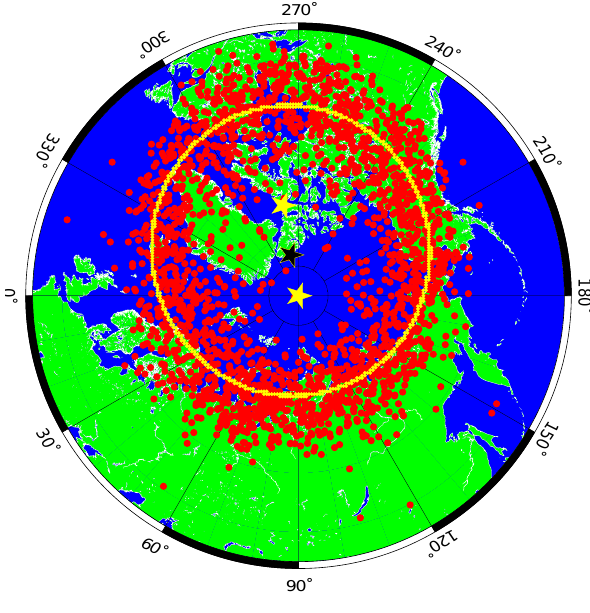
Fig. 4. Ellipse fit to the distribution of Formosat-3/COSMIC pro- files which statisfy the ELDI condition. The yellow stars mark the focal points of the ellipse, the black star marks the center point of the circle